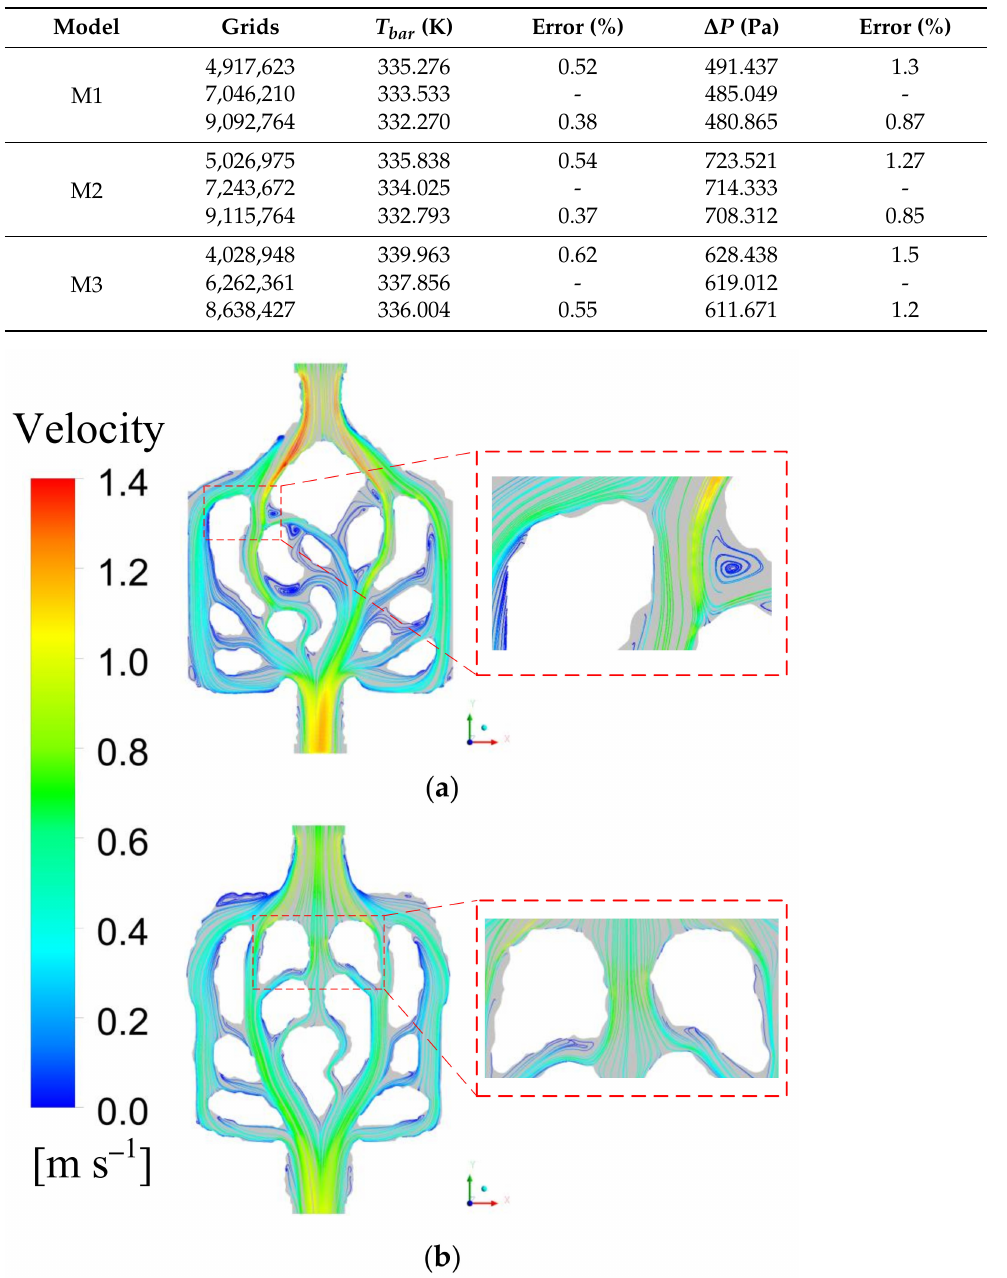
Table 5. Grid independence test result.